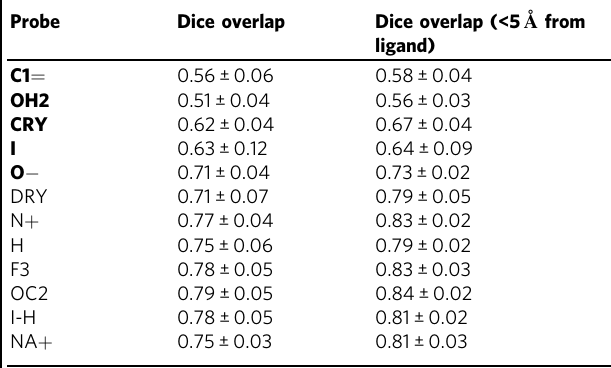
Dice overlapvalue forthecross-validationsetsaftershuf fl ingofgrid pointvalues foreachof the 12 MIF grids. The larger the change in value, the more important the probe grid is for the prediction. Important probe grids are displayed in bold. The un-shuf fl ed dice overlap values are shown in Table 1 for all grid points and grid points around